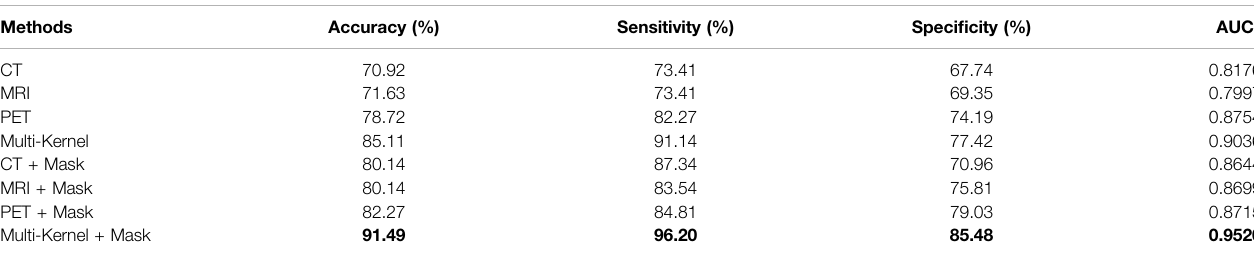
TABLE 3 | Prediction performance of different predictive methods.